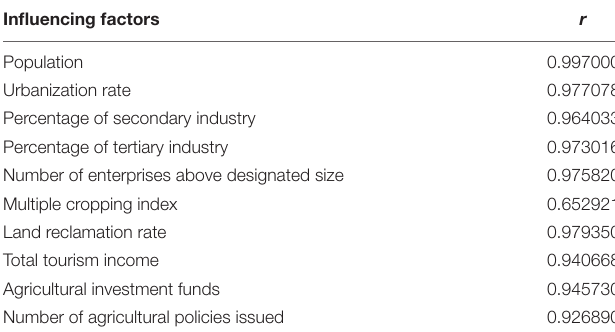
TABLE 2 | Gray correlation degree between the evolution of cultivated land functions and social economic factors in Henan